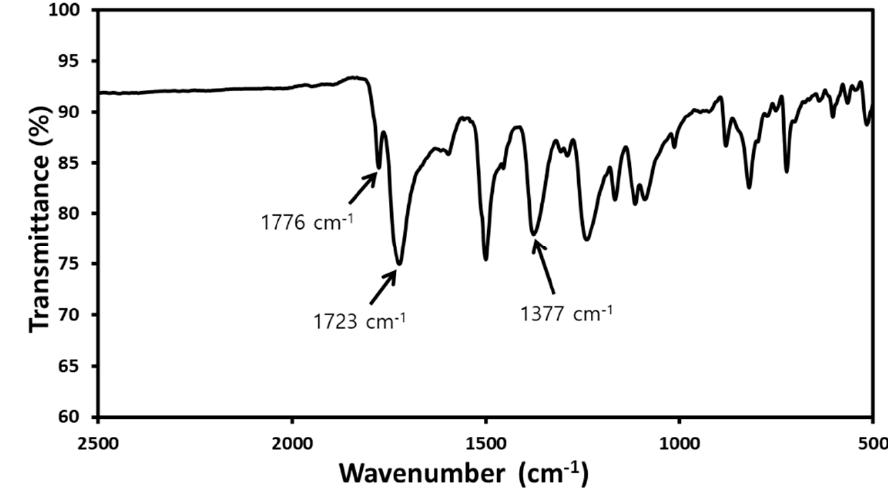
Figure 6. FT-IR spectrum of the prepared polyHIPE.